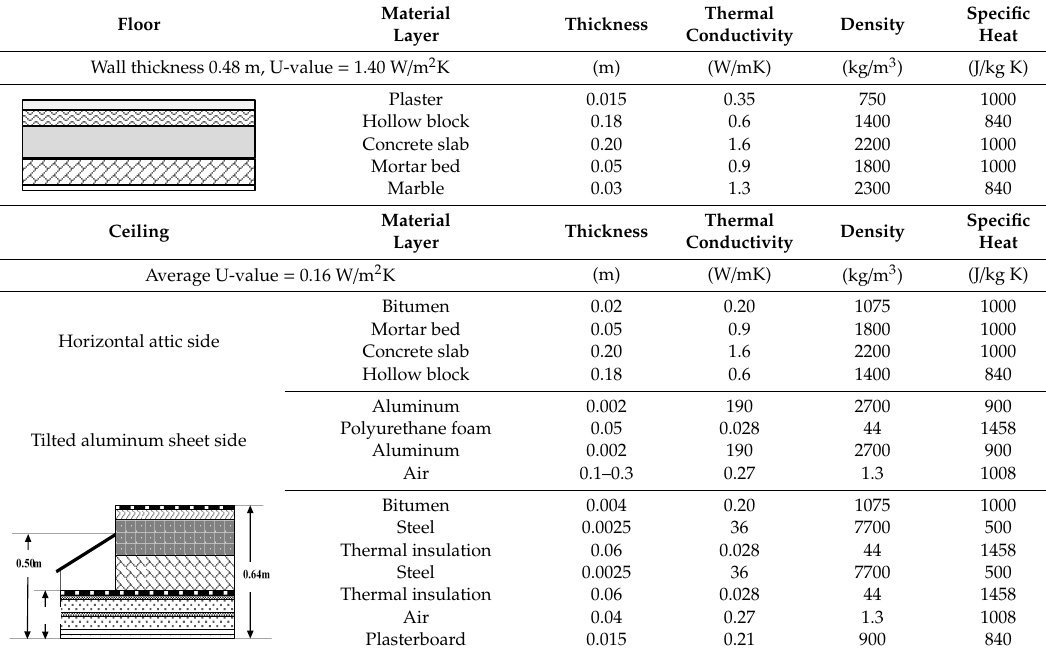
Table 2. Ceiling and floor layers thickness and thermophysical properties (from outdoor to indoor).